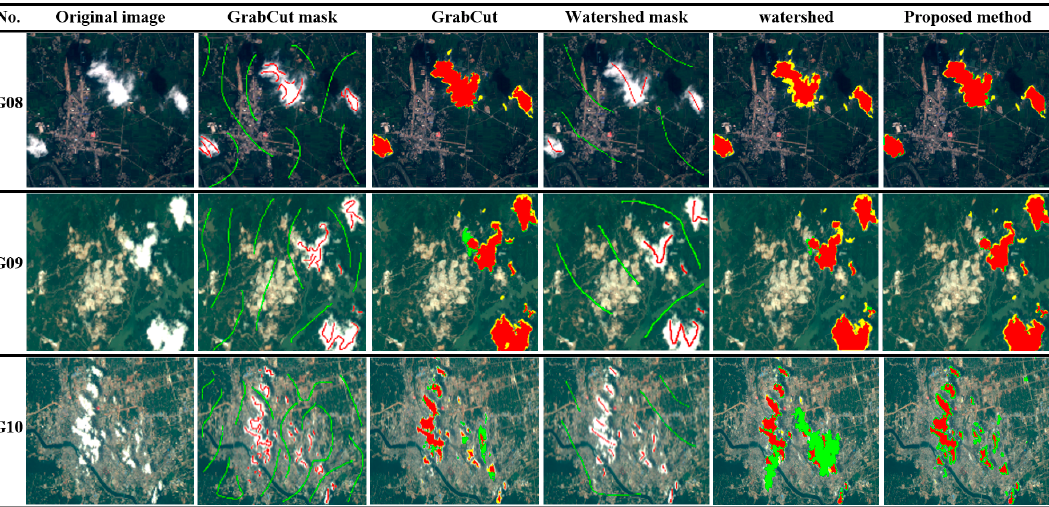
Figure 18. Results of comparison with interactive image segmentation algorithms (Red regions in the columns of GrabCut, watershed and the proposed method denote the extracted true cloud regions, yellow denotes the missed cloud regions, and green denotes the non-cloud regions that were misjudged as cloud regions. The green scribbles in the columns of the GrabCut mask and the Watershed mask indicate non-cloud regions, and the red scribbles indicate cloud pixels).